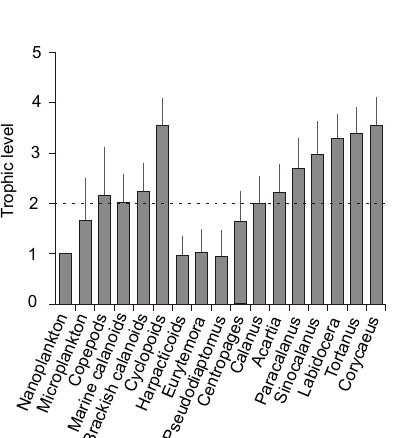
δ 13 C values ( − 16.7 ± 1.4 ‰) of Harpacticoids were rela- tively higher than other groups.